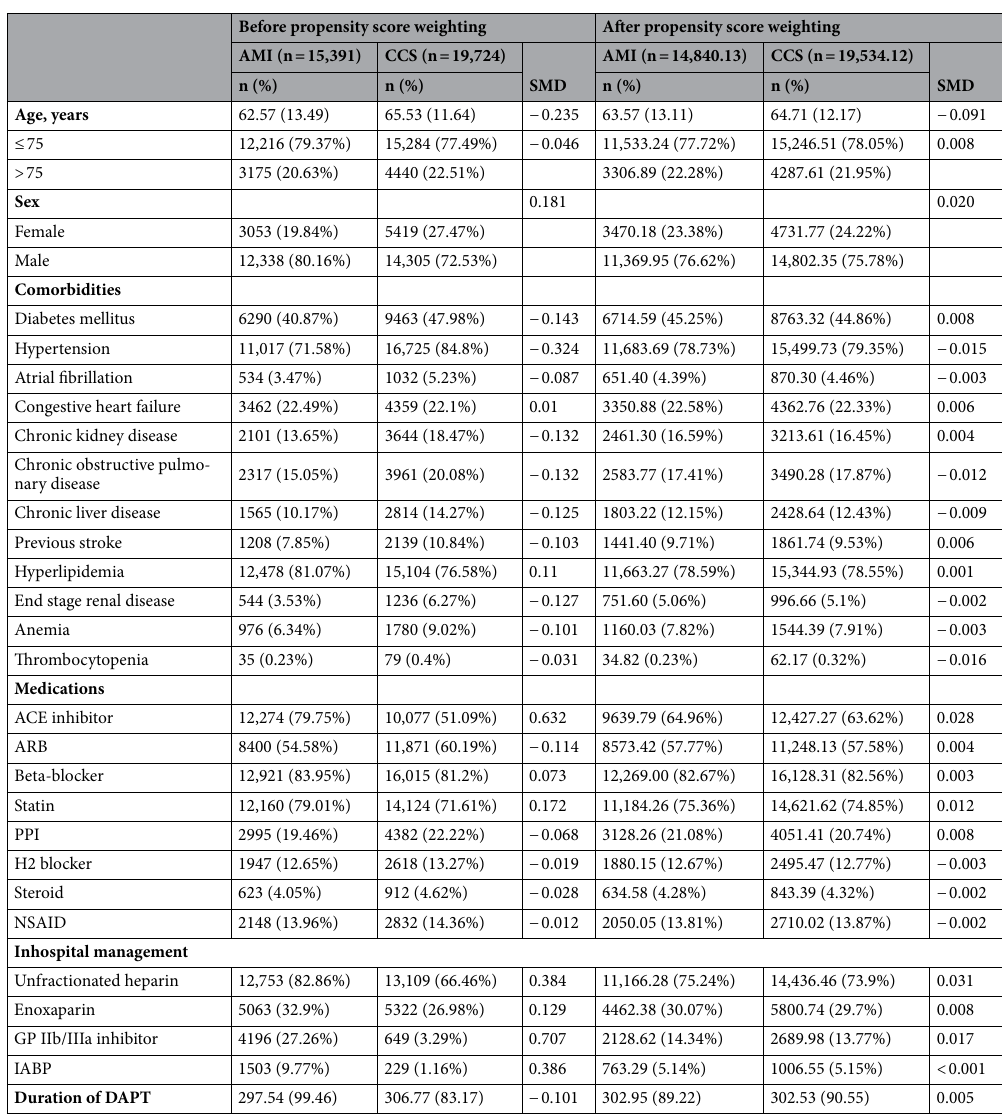
Table 1. Demographics and clinical characteristics of patients with AMI and CCS who had received DAPT after coronary stenting. ACE angiotensin-converting enzyme, AMI acute myocardial infarction, ARB angiotensin II receptor blocker, CCS chronic coronary syndrome, DAPT dual antiplatelet therapy, GP glycoprotein, IABP intra-aortic balloon pump, NSAID nonsteroidal anti-inflammatory drug, PPI proton-pump inhibitor, SMD standardized mean